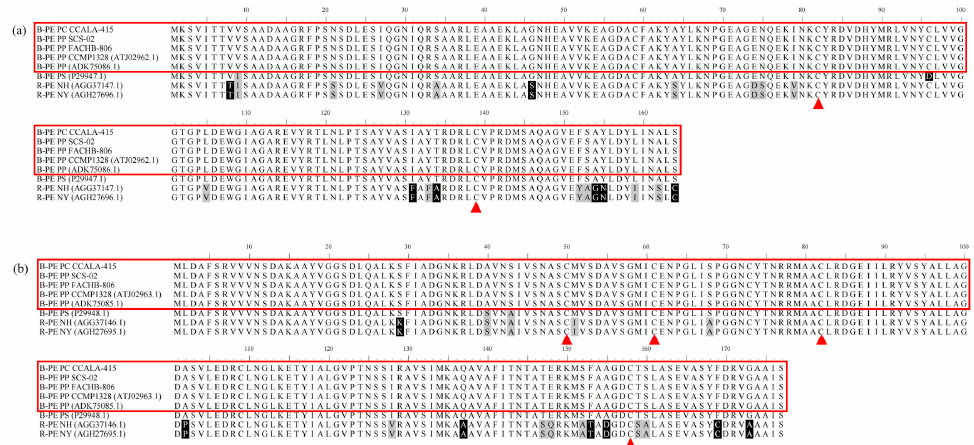
Figure 4. Amino acid sequence alignment of α subunit ( a ) and β subunit ( b ) of phycoerythrin from CCALA-415, SCS-02 and FACHB-806. PP: Porphyridium purpureum ; PC: Porphyridium cruentum ; PS: Porphyridium sordidum ; NH: Neopyropia haitanensis ; NY: Neopyropia yezoensis . Black shading indicates completely different amino acids; gray shading indicates similar amino acids; the label ▲ is the position where the subunit is attached to the chromophore.